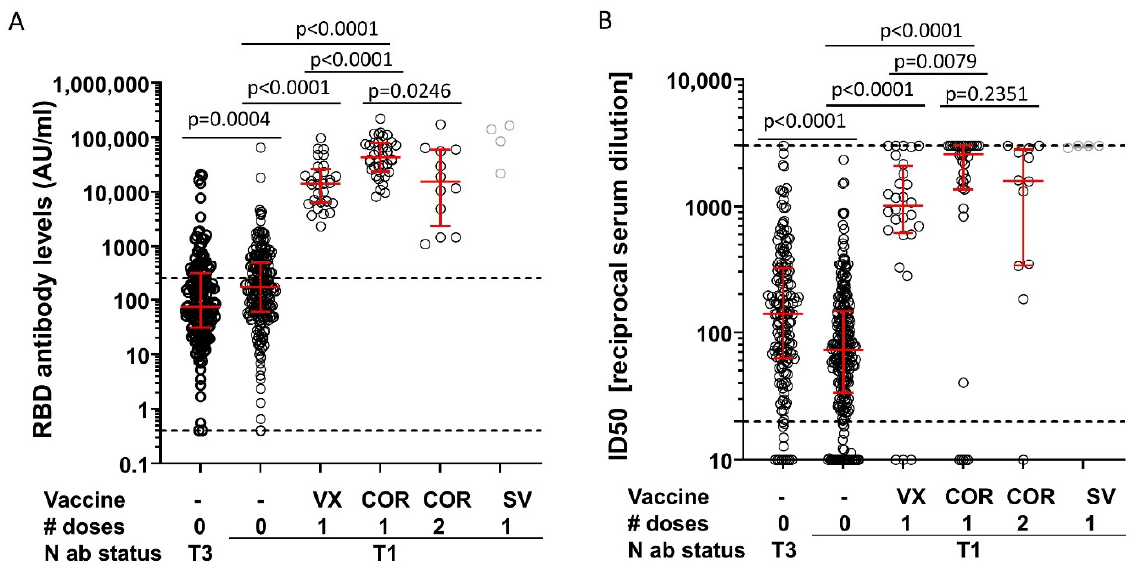
Figure 1. Antibody responses in infected participants. Shown are antibody levels to the receptor- binding domain (RBD) of the S protein (Roche Elecsys Anti-SARS-CoV-2 S test; arbitrary units AU) ( A ) and neutralizing antibody levels (ID50) ( B ) in seropositive participants receiving the indicated number of doses of Vaxzevria (VX), Comirnaty (COR), or SpikeVax (SV). Median and interquartile range are indicated by red bars. The Kruskal–Wallis test including all five groups with more than six participants indicated significant differences for the RBD and neutralizing antibody levels ( p < 0.0001 for both, judged at 5% significance level). Pairwise comparisons were performed to (i) analyze a potential waning of immune responses after infection (0 dose T3 vs. 0 dose T1), (ii) determine and compare the effect of one dose of Vaxzevria and Corminaty (0 dose T1 vs. 1 dose VX vs. 1 dose COR) and (iii) explore the effect of a second dose of Cormirnaty (1 dose COR vs. 2 dose COR). p -values of these pairwise group comparisons with the Mann–Whitney test are shown (judged for significance at a Bonferroni-corrected level of 0.05/5 = 0.01 to account for 5 tests). N antibody (ab) status: T1: participants that were N-antibody positive already at the June 2020 visit; T3: participants negative for N antibodies at the June and November 2020 visits, but positive at the April 2021 visit. Dashed lines in ( A ) mark the upper and lower limits of the linear range of the assay, the dashed line in ( B ) mark the upper and lower limits of detection. Supplementary Tables S1 and S2 provide number of participants, basic demographic characteristics and the median time interval between the last immunization and blood sampling. # doses indicates the number of applied